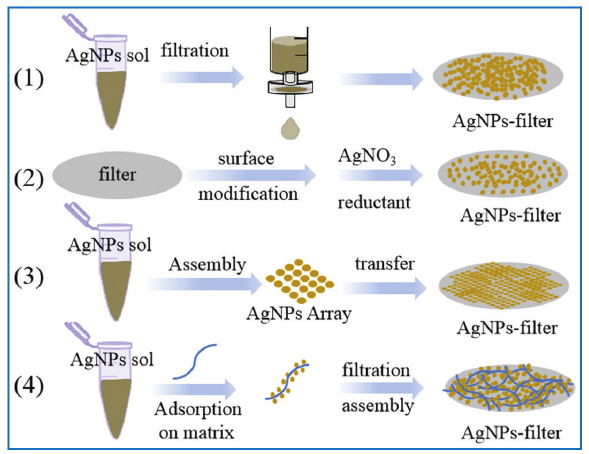
Scheme 1: Schematic the preparation of filter-based substrates using different approaches introduced in Section